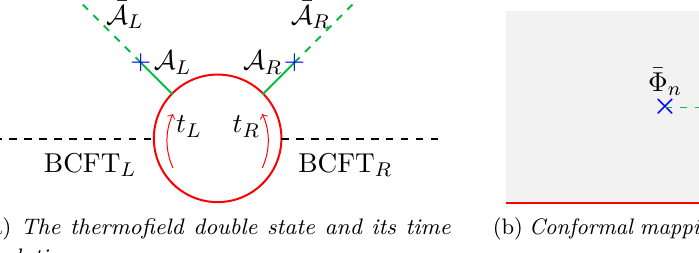
Figure 3 . a) The two Euclidean BCFTs L and R in the TFD state: time evolution is rotation with respect to the origin, hence the red circle is the time evolution of the boundary. The two black dashed lines define the zero time slice. Under the chosen time evolution, L and R evolve clockwise and counter-clockwise respectively, as indicated. We are interested in the entanglement entropy of the subsystem A = A L ∪ A R corresponding to the solid green line segments. b) The UHP which results from the conformal mapping of the region outside of the red circle in figure 3a. The circular (cid:0) (cid:1) boundary is mapped to the real axis and infinity is mapped to 0 , 1 . The location of twist operators 2 is mapped to the two blue crosses, separated in the horizontal direction. The branch cut is mapped (and deformed) to the dashed green line connecting the two